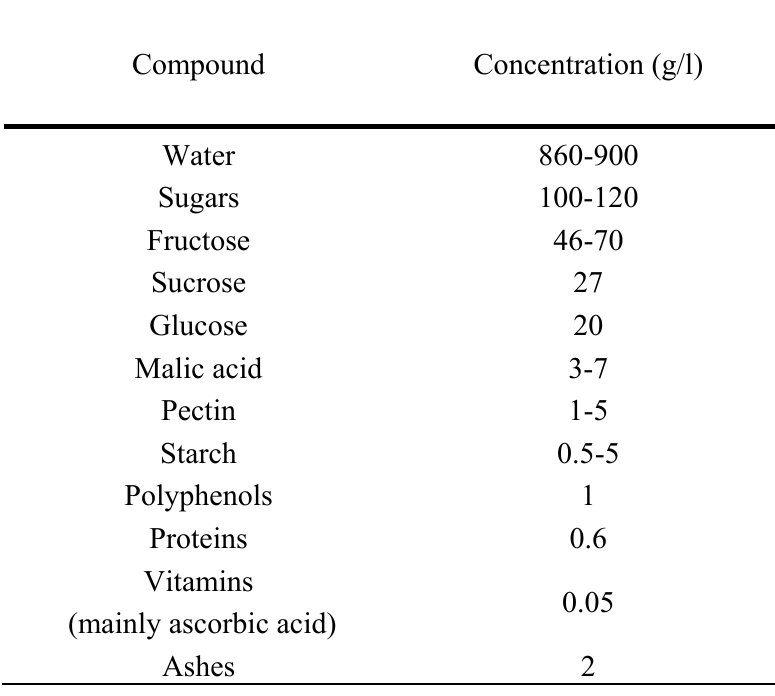
Table 1. Approximate composition of apple juice components. For each compound the correspondent concentration (g/l) contained in apple juice is